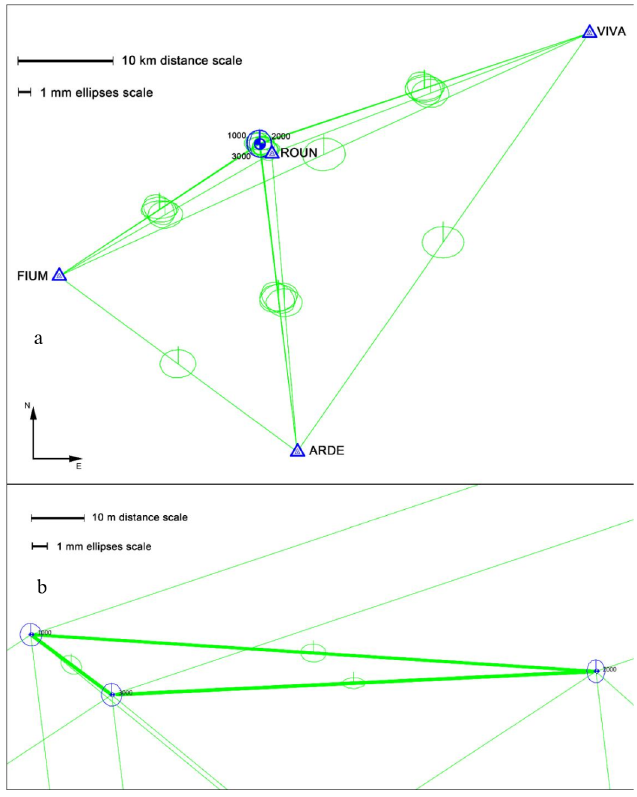
Figure 1. Reference network (Lazio GNSS permanent stations, ETRF2000) ( a ), detail of the local GNSS network (Rome, Piazza del Parlamento) ( b ). Table 1. GNSS permanent stations utilised for the ETRF2000 datum